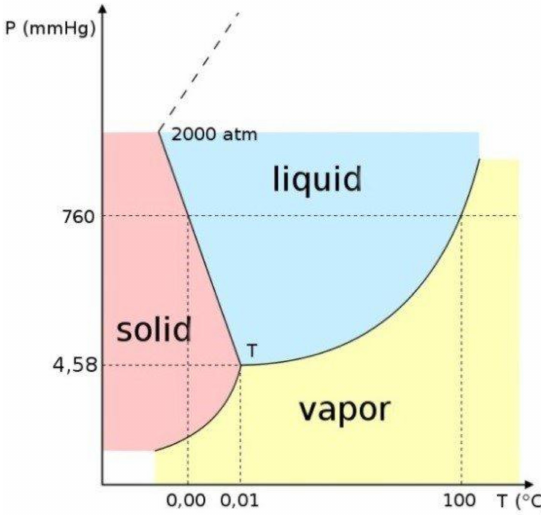
Figure 7. Pressure–Temperature diagram of